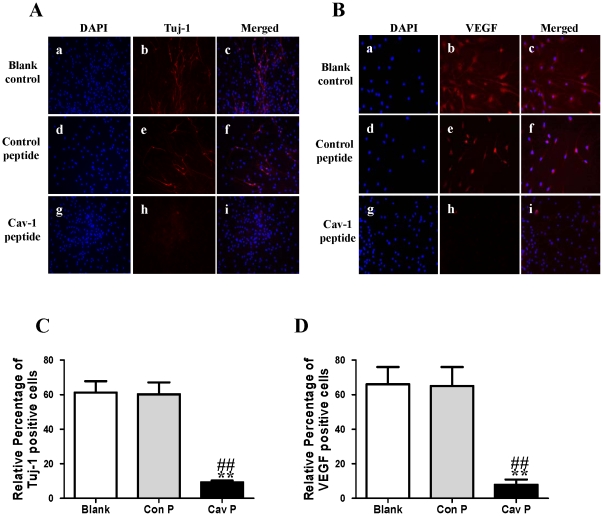
Effects of Cav-1 scaffolding domain peptide on the expressions of Tuj-1 and VEGF protein in NPCs under hypoxia-reoxygenation condition.Similar experimental protocols as Figure 9 were used in the experiments and data were obtained from the samples at day 14. A–B: Representative immunofluorescent imaging of Tuj-1 and VEGF in the hypoxic NPCs at day 14. Red color: Tuj-1 and VEGF staining; Tuj-1 and VEGF staining (red color) were identified in blank control group (a, b, c), control peptide group (d, e, f) and Cav-1 peptide group (g, h, i). Nuclear localizations of Tuj-1 and VEGF were verified by co-localization with DAPI staining (blue color). C–D. Statistical analysis on the relative percentage of Tuj-1 and VEGF positive cells in NPCs (Mean ± S.D., n = 6). Blank, blank control group; Con P, Cav-1 scrambled control peptide; Cav P, Cav-1 scaffolding domain peptide group. Cav P versus blank, ** p<0.01; Cav P versus Con P, ## p<0.01.